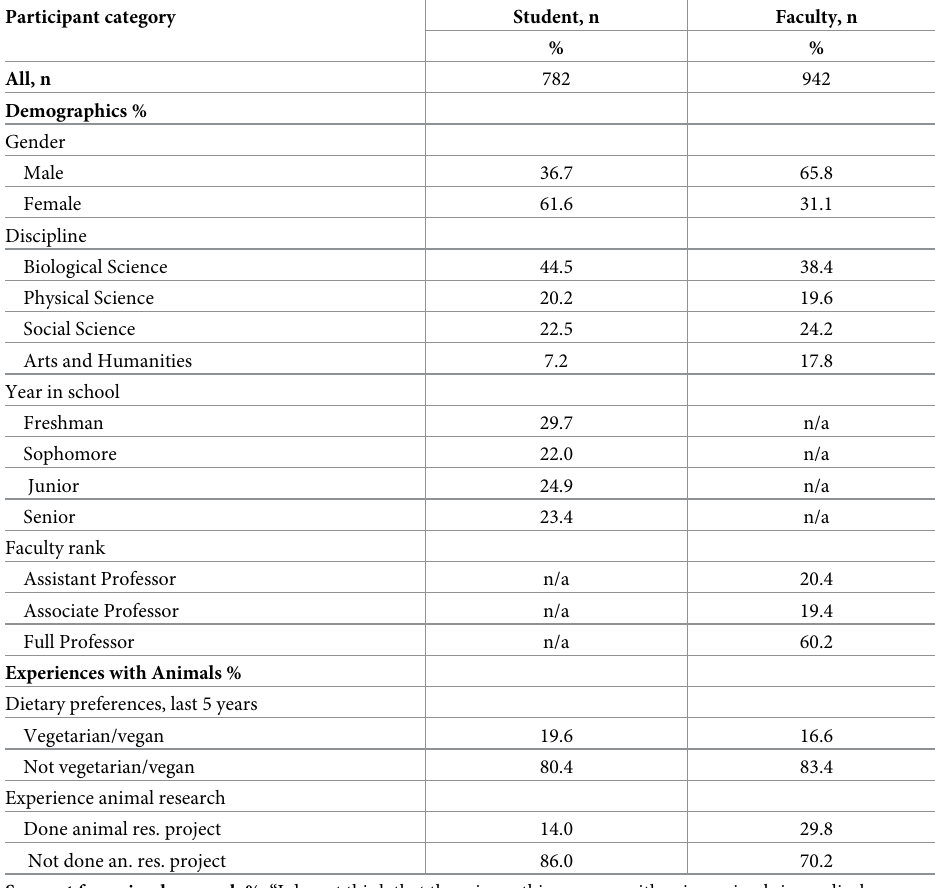
Table 1. Categories and numbers of survey participants 1